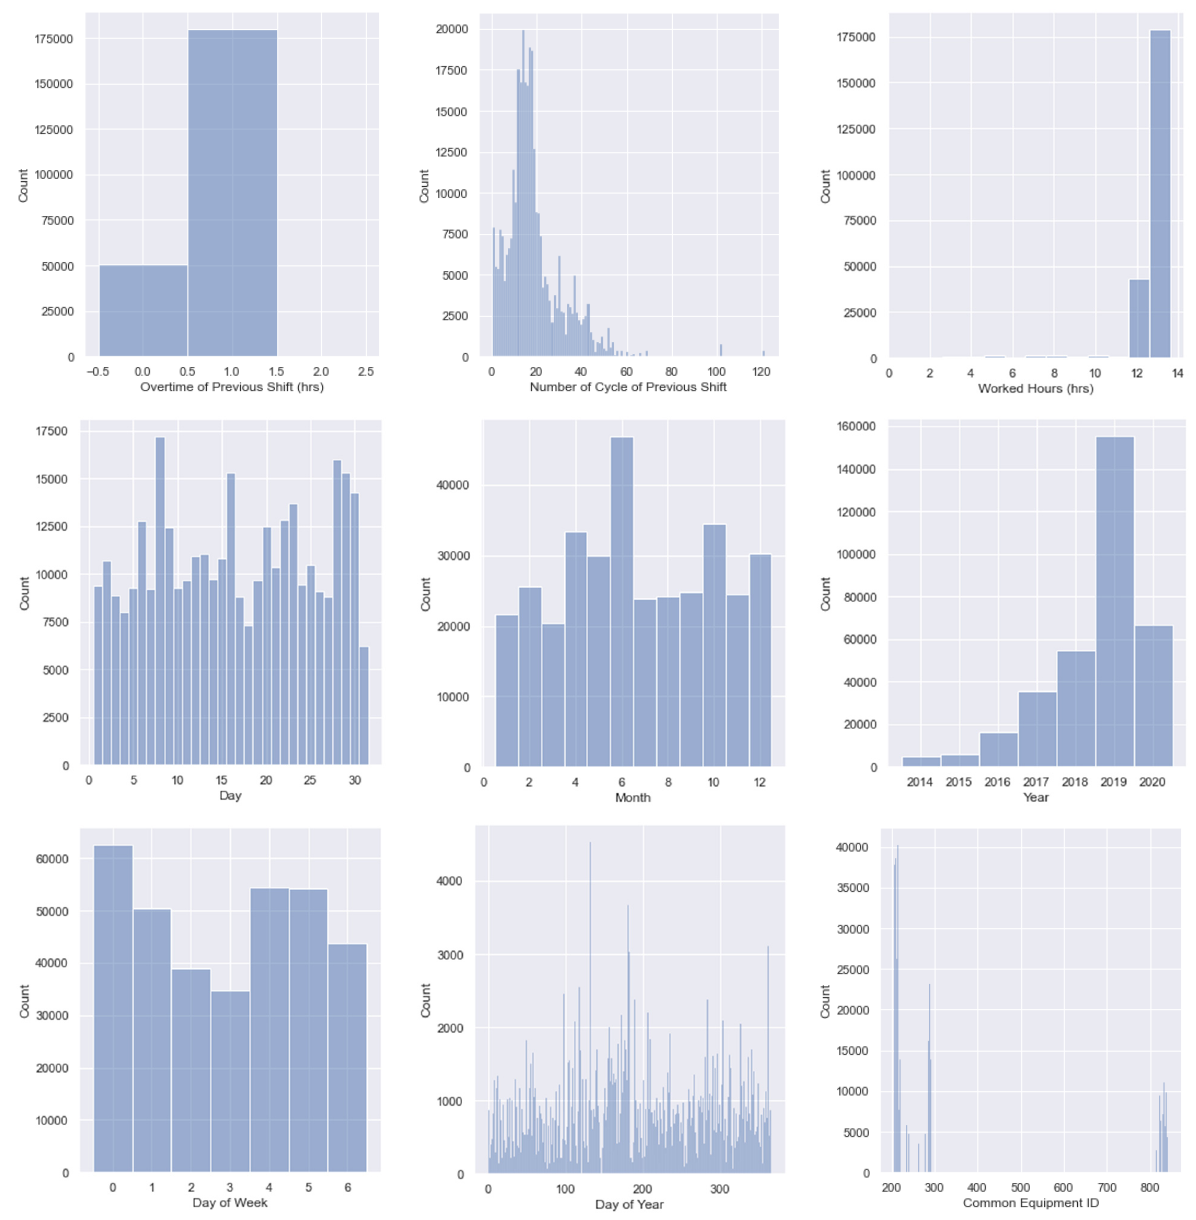
Figure 1. Distribution of the variables.